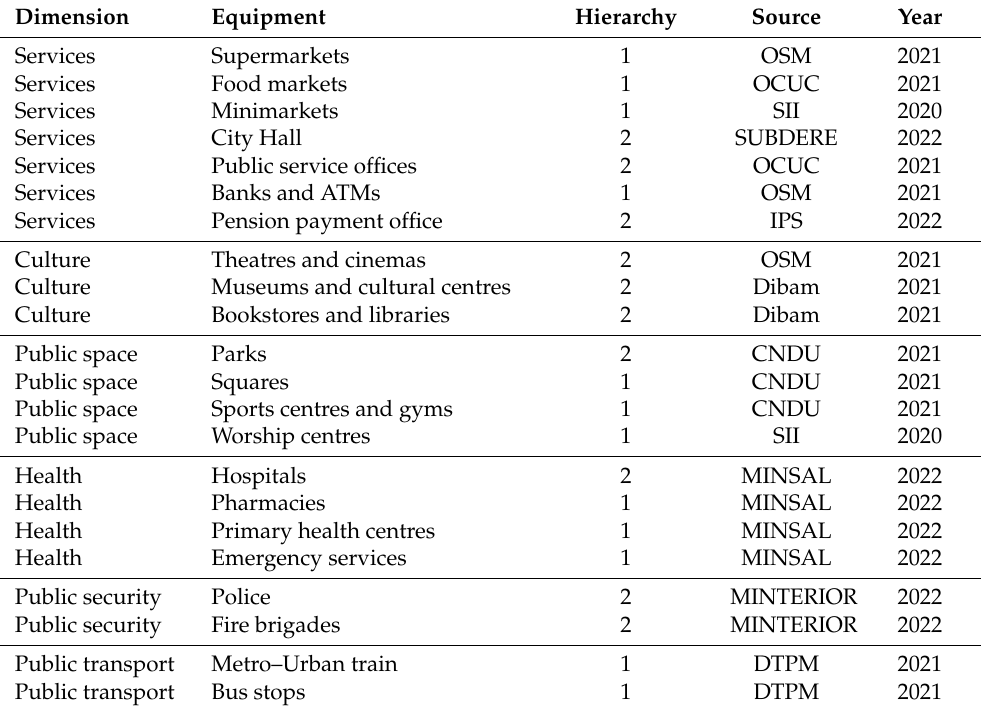
Table 1. Dimensions and facilities making up the 15-min accessibility index to the city. Dimension